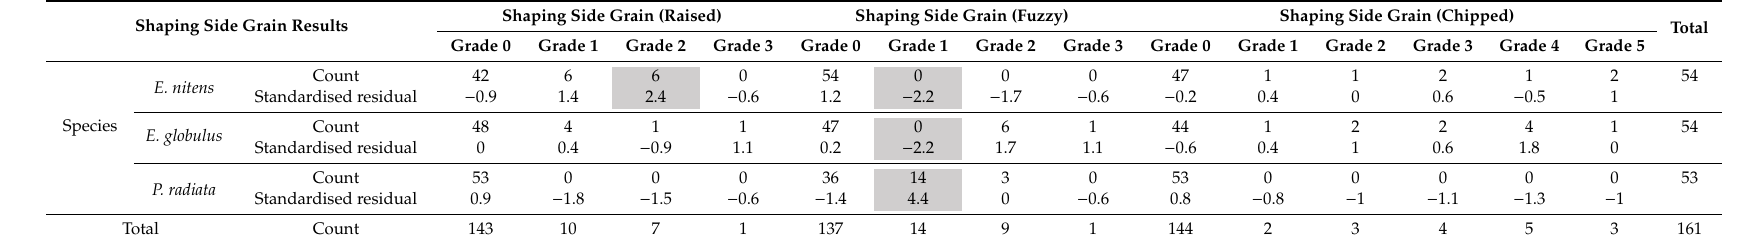
Table 4. Grading results according to shaping side